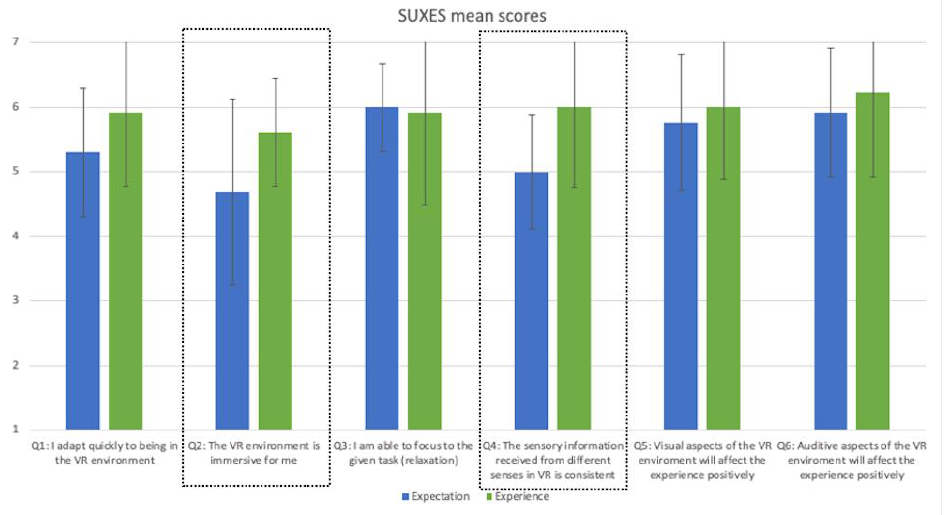
Figure 4. SUXES results. Bars indicate the means of subjective evaluations of expectations and post-intervention experiences regarding the application used. In Q2 and Q4, the change was statistically significant.